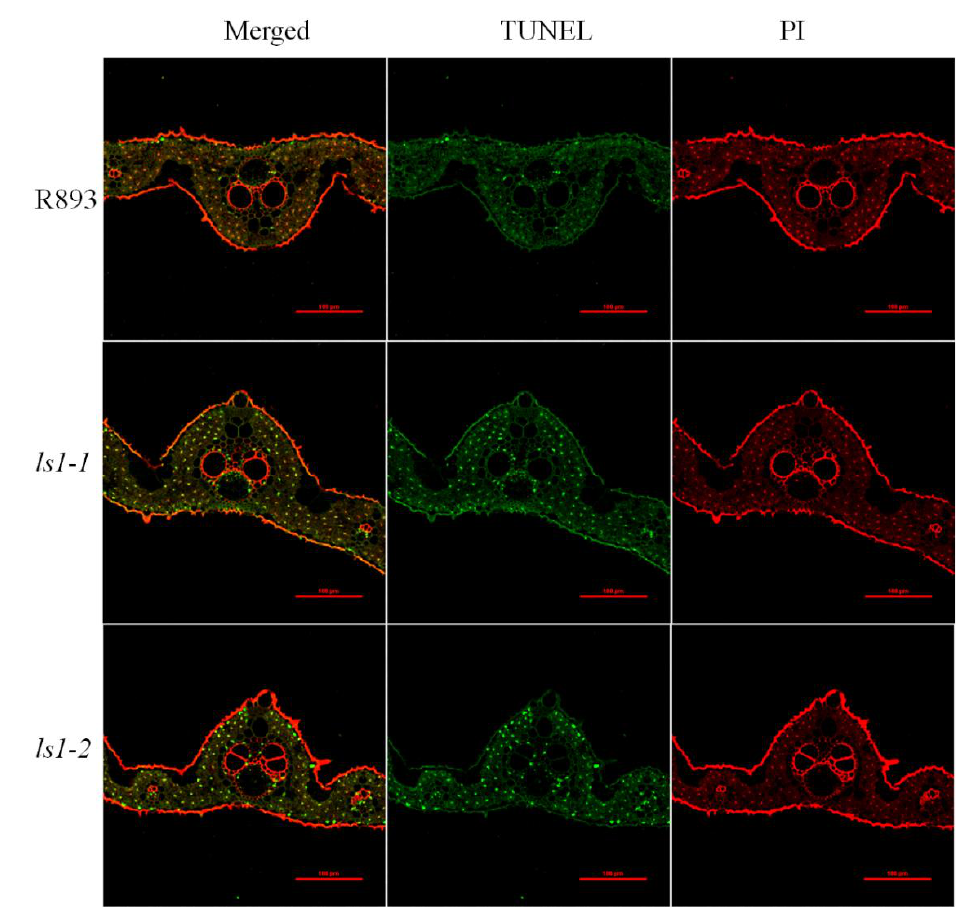
Figure 5. Programmed cell death ( PCD) detection in the leaves of ls1 plants. The red signal represents staining with propidium iodide (PI); yellow and green signals indicate TUNEL-positive nuclei of dead cells due to PCD. WT and ls1 leaves were analyzed at the heading stage. The green fluorescence (520 nm) of apoptotic cells (TUNEL) in a red (620 nm) background (propidium iodide, PI) was detected with a Zeiss LSM880 confocal laser scanning microscope. Scale bar = 100 μm.